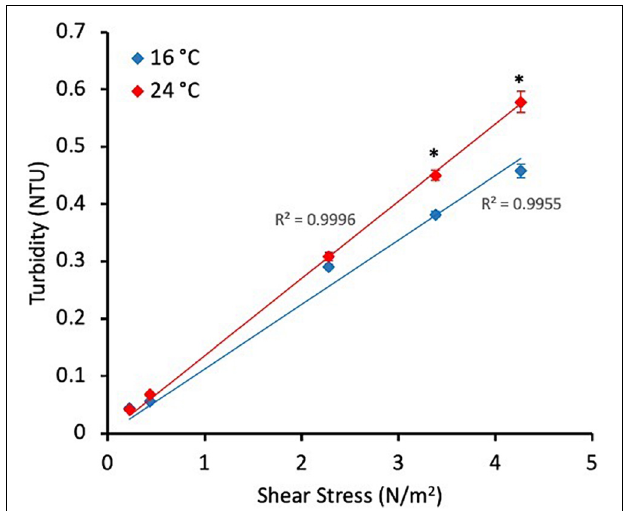
FIGURE 1 | Average turbidity response during the last 24 h of the growth phase (representative of the growth phase) and during the last turnover of each stage of the flushes (i.e., when the water with the mobilised material was mixed) at different temperatures. All values represent an average ± standard deviation. ∗ p -value ≤ 0.05 from Mann–Whitney U